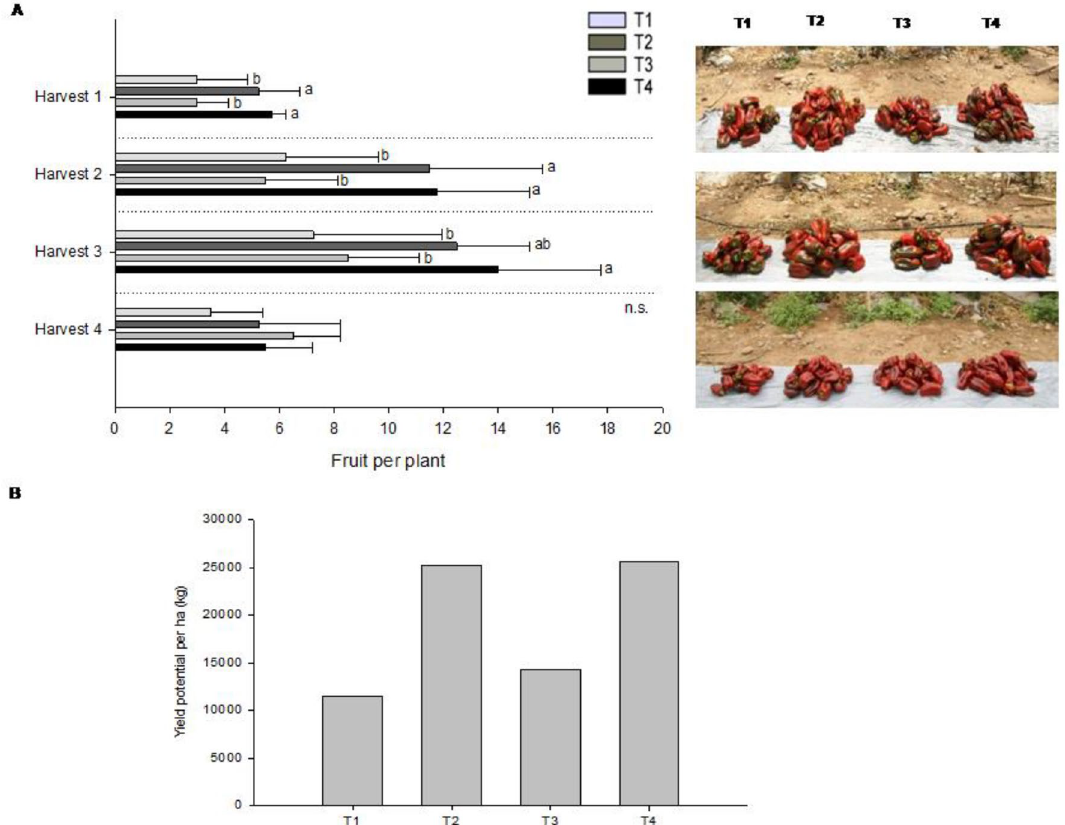
Figure 3. Effect of B. velezensis BBC047 application on bell pepper productivity and yield in productive greenhouse. ( A ) Fruit production per treatment in four representative harvests (bars indicate average of harvested fruits per plant and treatment, statistical differences determined with ANOVA ( p < 0.05) and Post- Hoc-LSD Fisher test), photographs by R. Salvatierra-Martinez; pictures right: piled fruits from one replicate per treatment and harvest. ( B ) Extrapolation of the yield obtained per treatment in